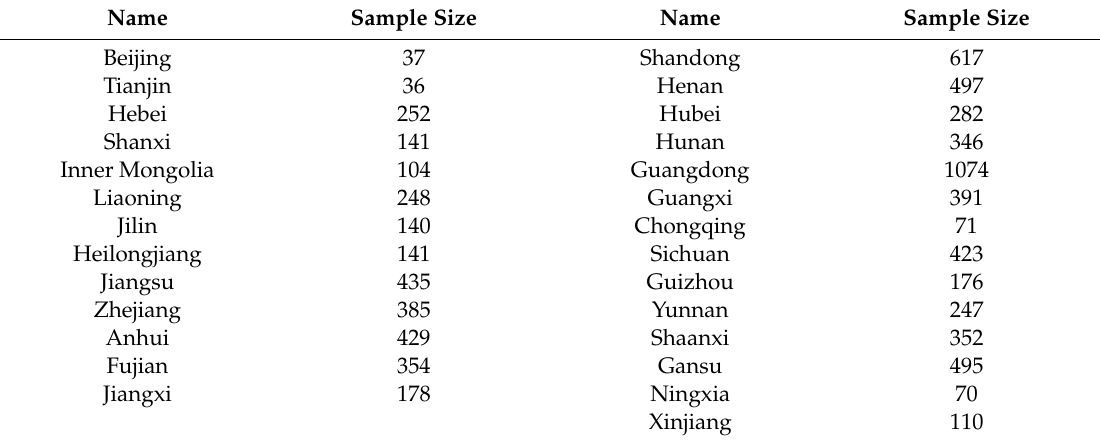
Table A1. Sample distribution of each sample